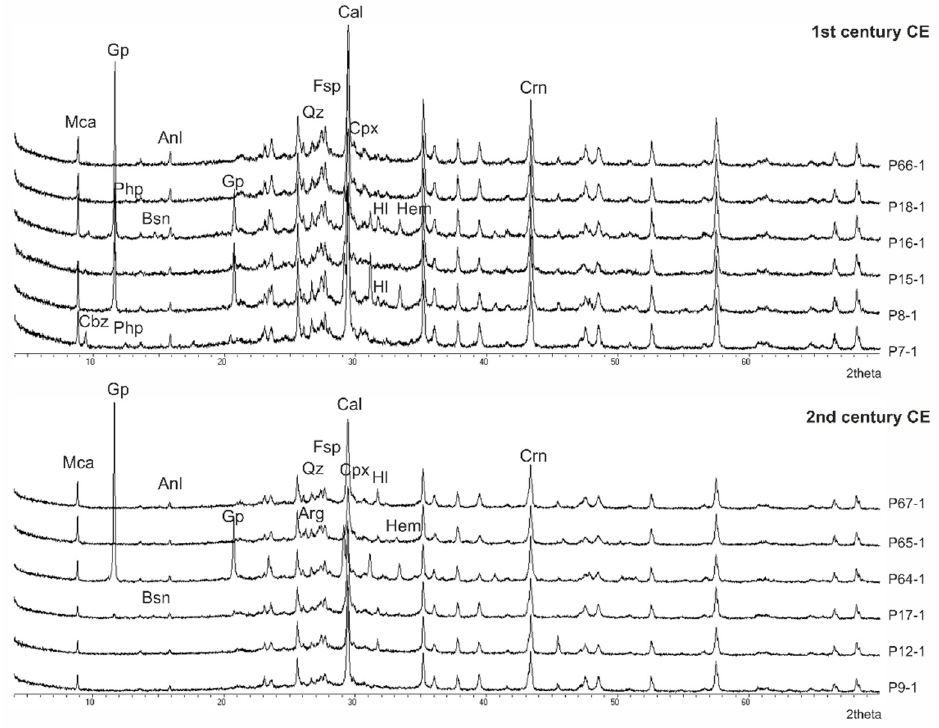
Figure 4. XRPD patterns of the investigated mortar samples of 1st and 2nd century CE. Where ap- plicable, abbreviations according to [43]: Cal = calcite; Anl = analcime; Php = phillipsite; Cbz = chab- azite; Fsp = feldpar; Mca = mica; Gp = gypsum; Hl = halite; Qz = quartz; Arg = aragonite; Cpx = clinopyroxene; Bsn = bassanite; Crn = corundum (20% added as standard for future quantitative